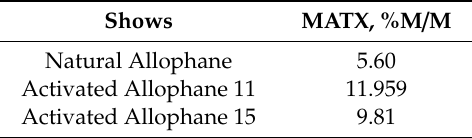
Table 27. Conversion rate of catalytic cracking of di ff erent